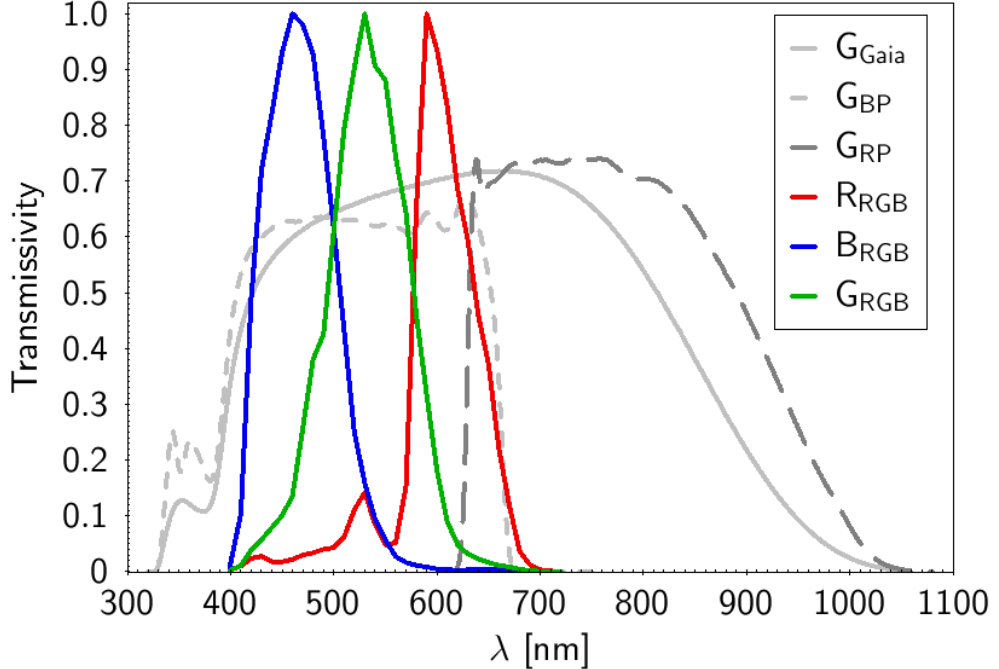
Figure 1. Comparison of RGB transmissivity curves (in colour lines) used in this work, extracted from [1] with the Gaia DR3 transmissivity curves by [9] (in grey). In order to distinguish between the G passband from the RGB system and the G passband from the Gaia system, we add ’RGB’ as a subscript to the first and ’Gaia’ as a subscript to the